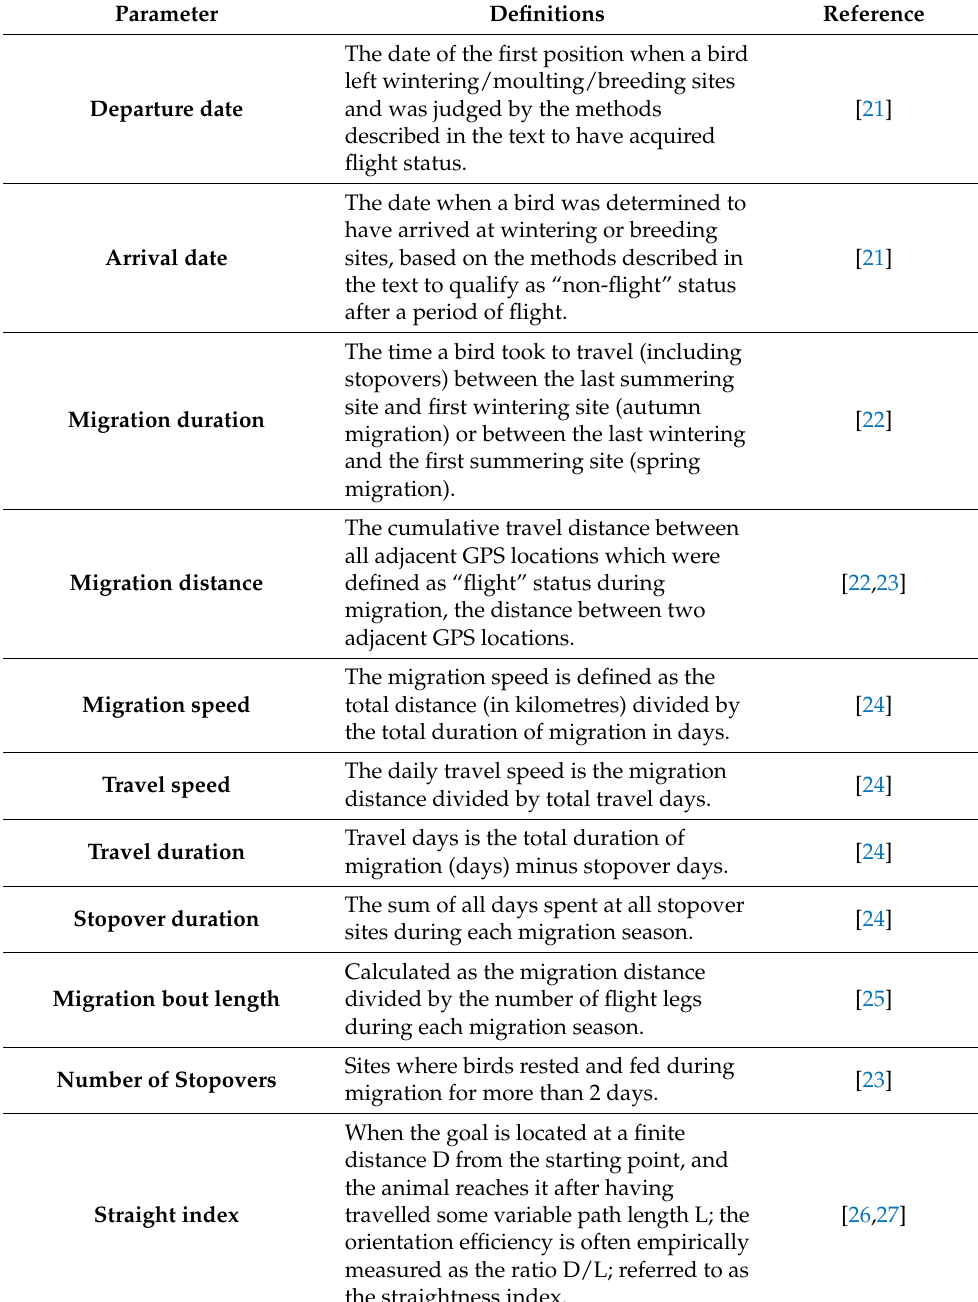
Table 1. Migration parameters of white-naped cranes Antigone vipio used in this analysis and their precise definitions as applied to the data analysis presented